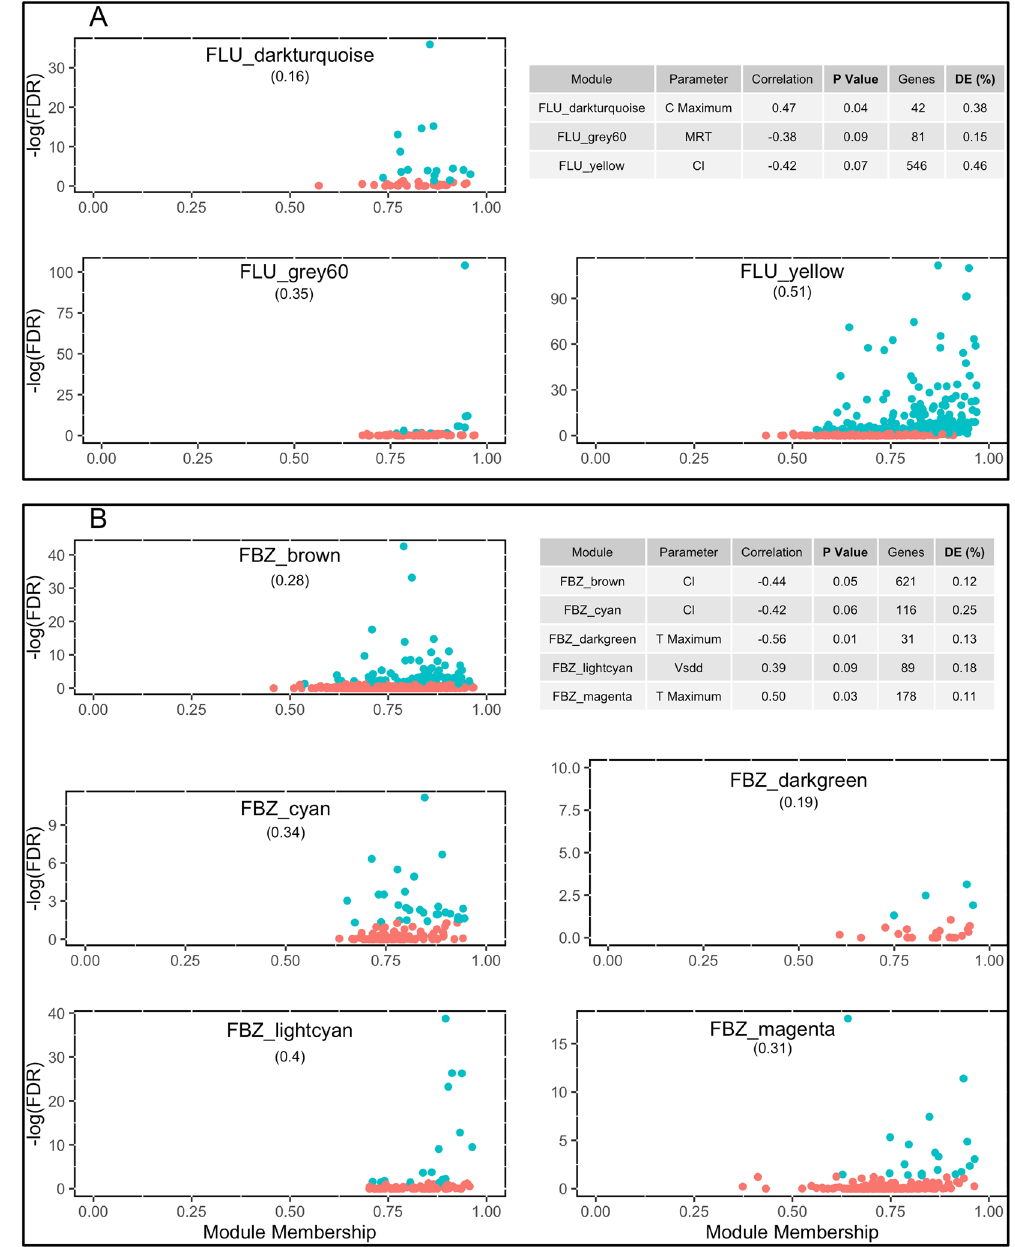
Figure 3. Significant modules associated with Flunixin Meglumin (i.e. Panel A) or Fenbendazole (Panel B) and the number of significant differentially expressed genes within each